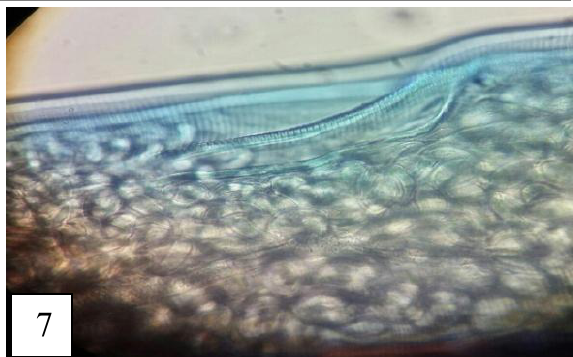
Figure, 7: Reveals the aggregated eggs in the oviduct